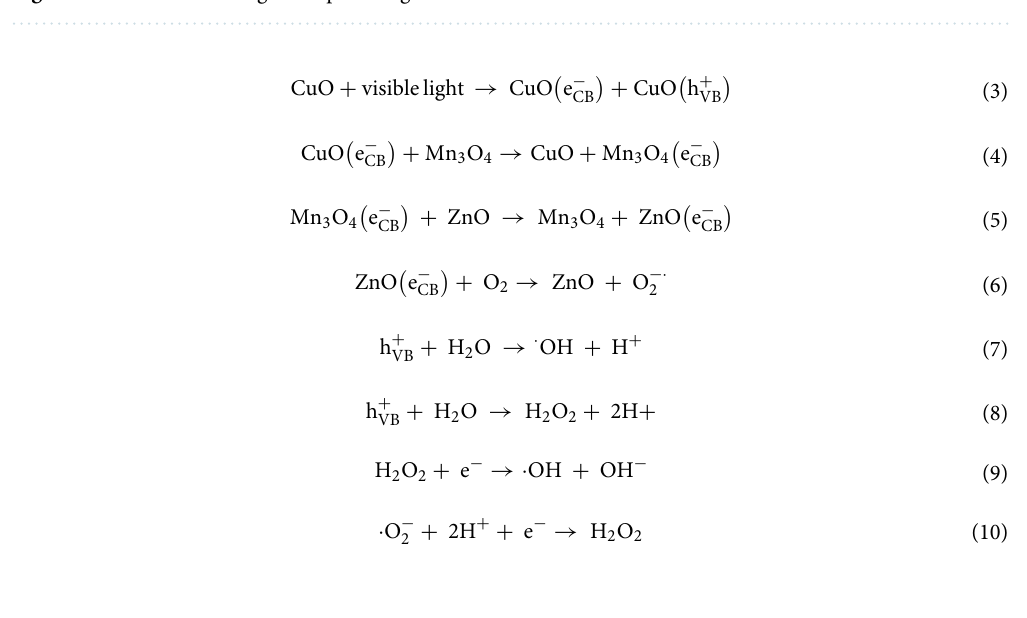
Figure 11. Effect of scavengers on